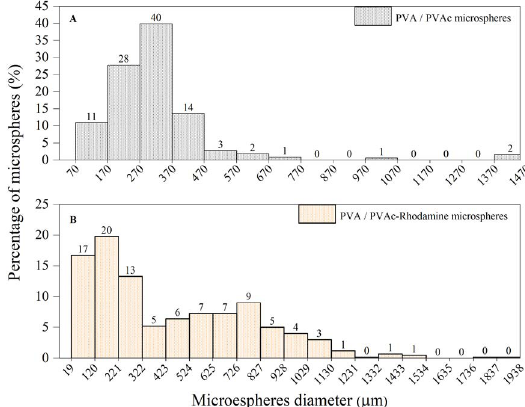
Figure 4. Size distribution of A) PVA/PVAc microspheres and B) PVA/PVAc-Rhodamine microspheres.